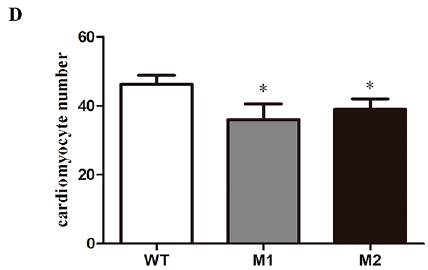
Figure 5. Decreased cardiomyocytes in pr130 − / − zebrafish. ( A ) Representative images of H&E staining of adult heart tissue at 40× magnification. Scale bars, 200 µm; ( B ) Higher magnification of the boxed regions (400× magnification). The heart tissues of WT, M1, and M2 were from the same region of heart. Scale bars, 20 µm; ( C ) Pr130 − / − exhibited reduced cardiomyocytes. Red arrows indicate the myocardium nucleus. Scale bars, 10 µm; ( D ) The cardiomyocytes in heart tissues of controls and pr130 − / − adult zebrafish were quantified and presented in the bar graph. We calculated the number of cardiomyocytes in each of four chosen fields per fish at a magnification of 1000×. n = 16 hearts analyzed per panel. Data represent the mean ± SD. *, p < 0.05.